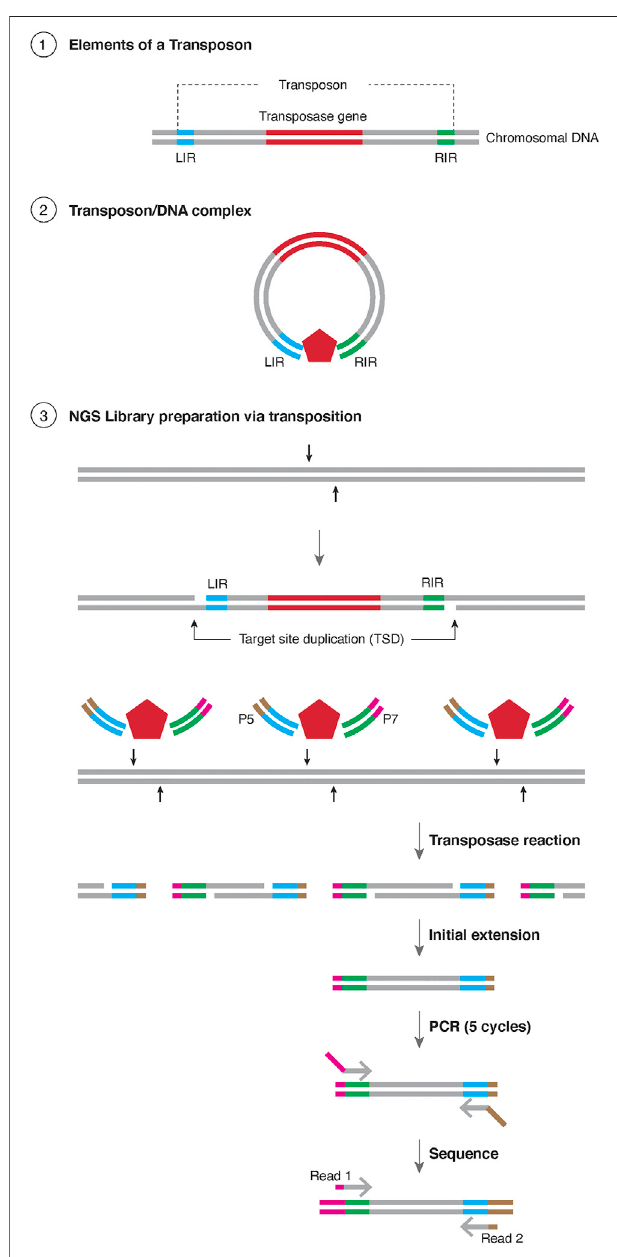
FIGURE 1 | Schematic representation of Tagmentation ① Representation of the elements of a transposon, with the transposase gene in red and the sequences for the Left Inverted Repeat (LIR) in blue and right inverted repeat (RIR) in green. The chromosome is represented as black lines. ② insertion of a transposon element resulting in Target Site Duplication (TSD). ③ Schematic representation of Tagmentation. A transposase (red pentagon) is in complex with DNA containing LIR and RIR, each containing either the sequence for Illumina P5 (brown) or P7 (magenta) sequences. The resulting transposase reaction results in TSD which is fi lled with initial extension, ampli fi ed for 5 rounds with PCR and the products are sequenced bidirectionally with Illumina